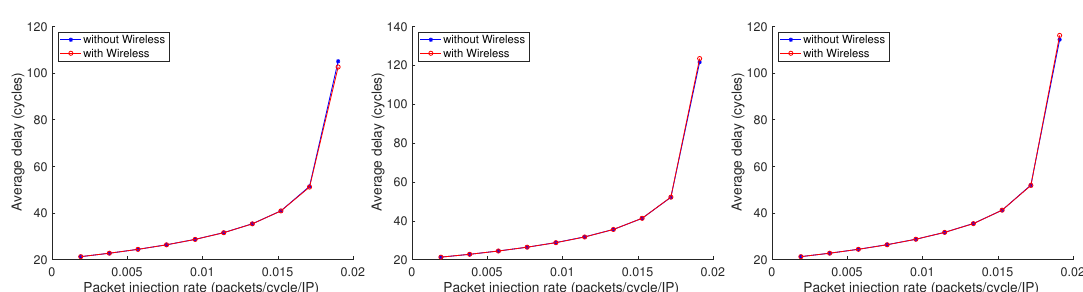
Figure 9. Average delay for profiles T 4 , T 8 , and T 16 for 256 Delta MIN topology and random traffic (TR-256 Delta MIN).